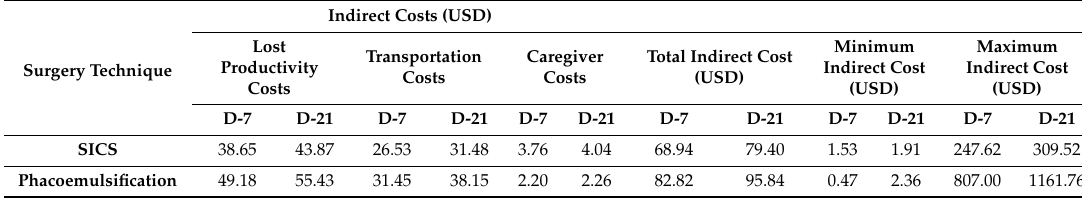
Table 2. Indirect Costs of Cataract Surgery Per Capita at Day 7 (D-7) and Day 21 (D-21).